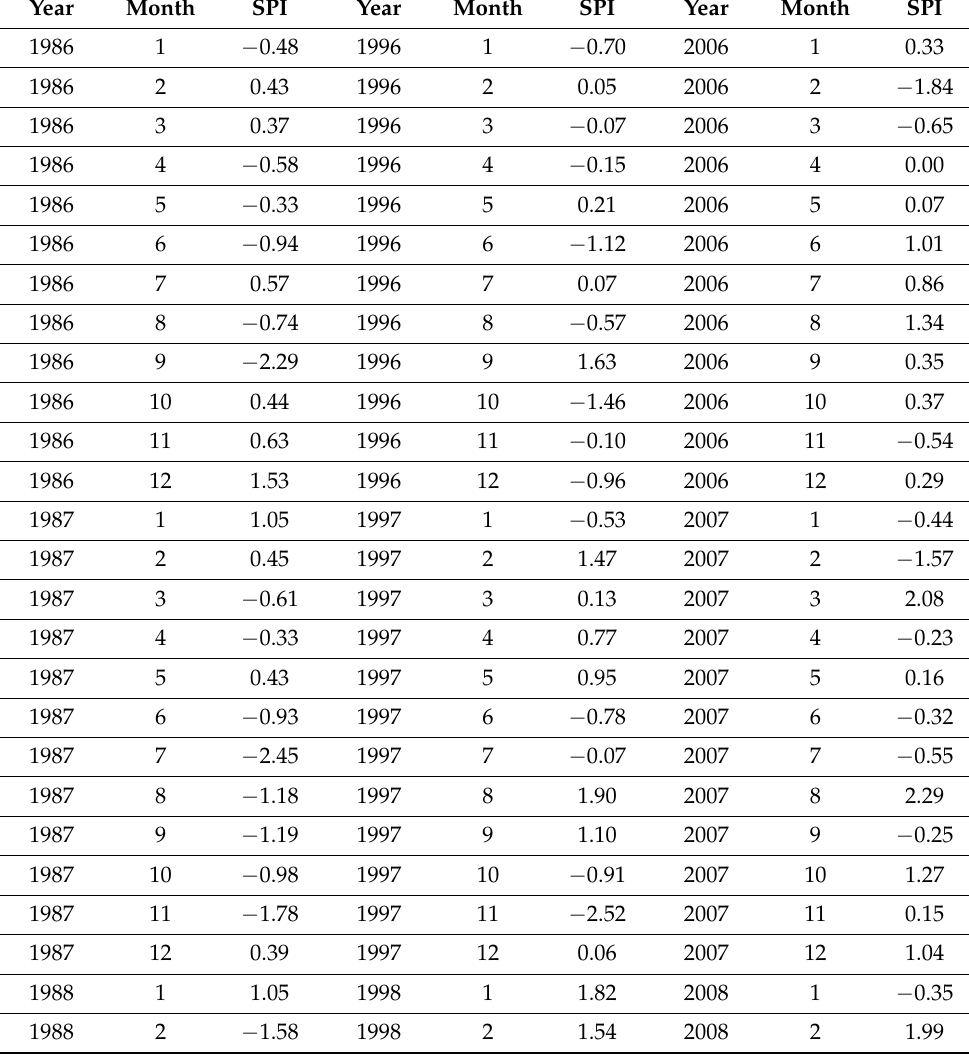
Table 4. Monthly SPI values of average rainfall condition in Nabadwip Municipality area